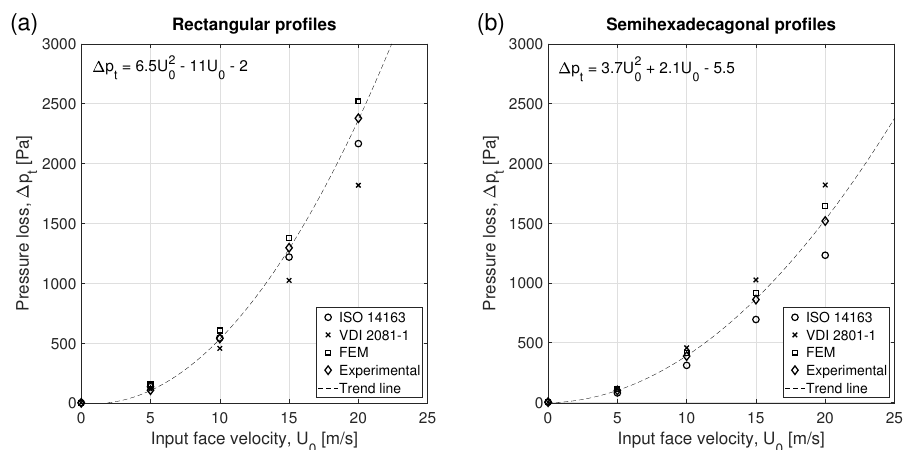
Figure 7. Pressure loss in splitter silencers with ( a ) rectangular and ( b ) semihexadecagonal profiles as a function of the input face velocity, U 0 . The dashed black lines show the trend lines followed by the experimental results, used to obtain the fitting